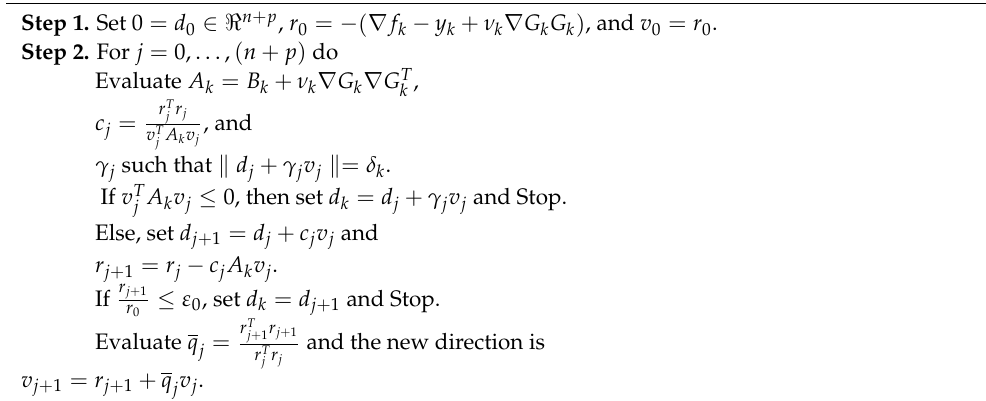
Algorithm 1 The algorithm of the conjugate gradient